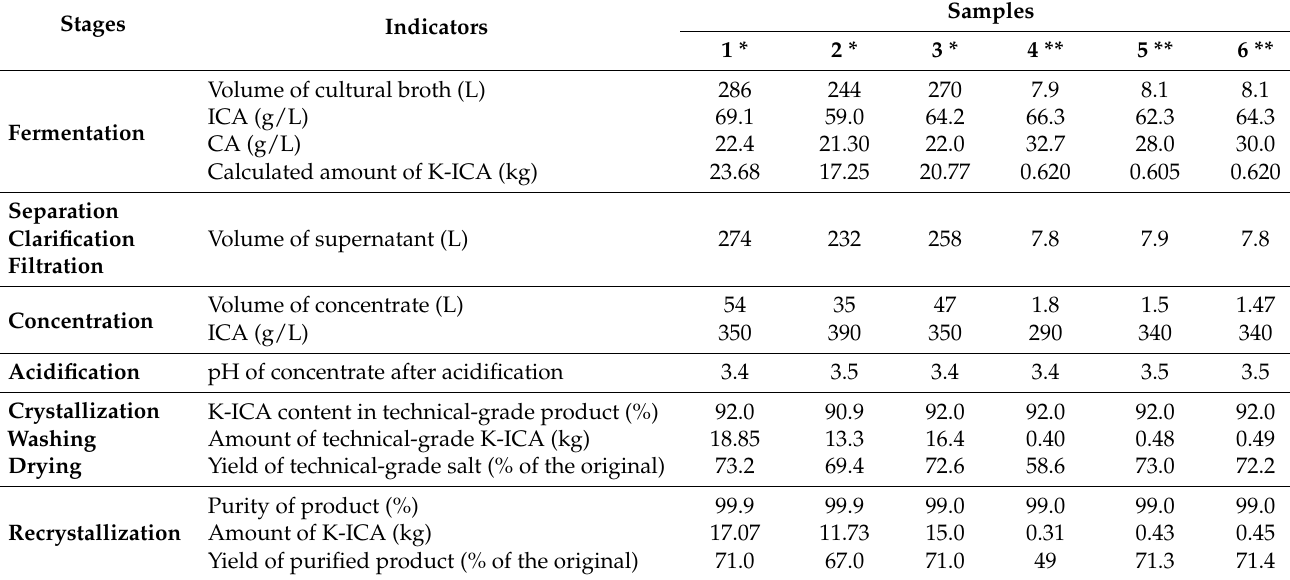
Table 2. Characteristics of yield and purity of monopotassium salt of